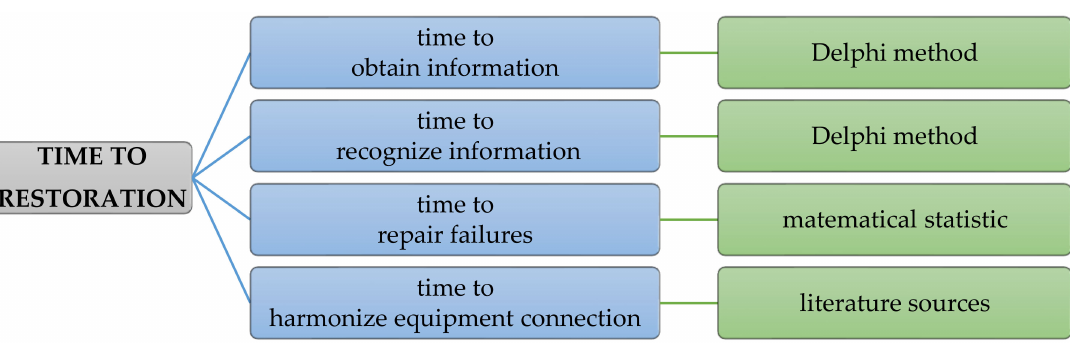
Figure 1. The proposed methodology to obtain restoration time for a selected power supply